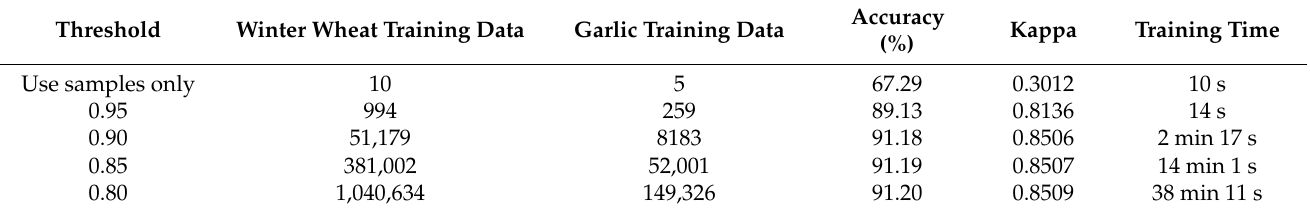
Table 3. Training data and accuracy of different